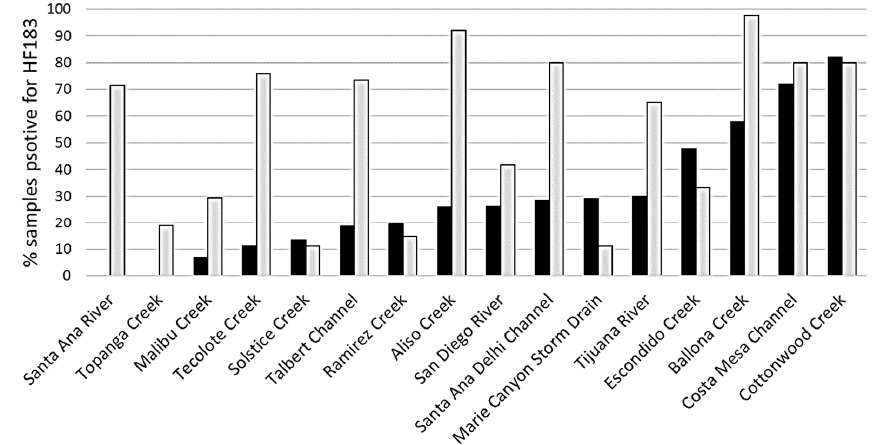
Figure 4. Frequency of HF183 detection by site in wet (light grey filled bars) versus dry (dark-filled) weather conditions. Frequency of HF183 detection is defined as % samples that are positive for HF183 and a sample is deemed positive for HF183 if the HF183 marker amplified in any of the three qPCR replicates. Sites are sorted from left to right by frequency of detection under dry weather conditions.